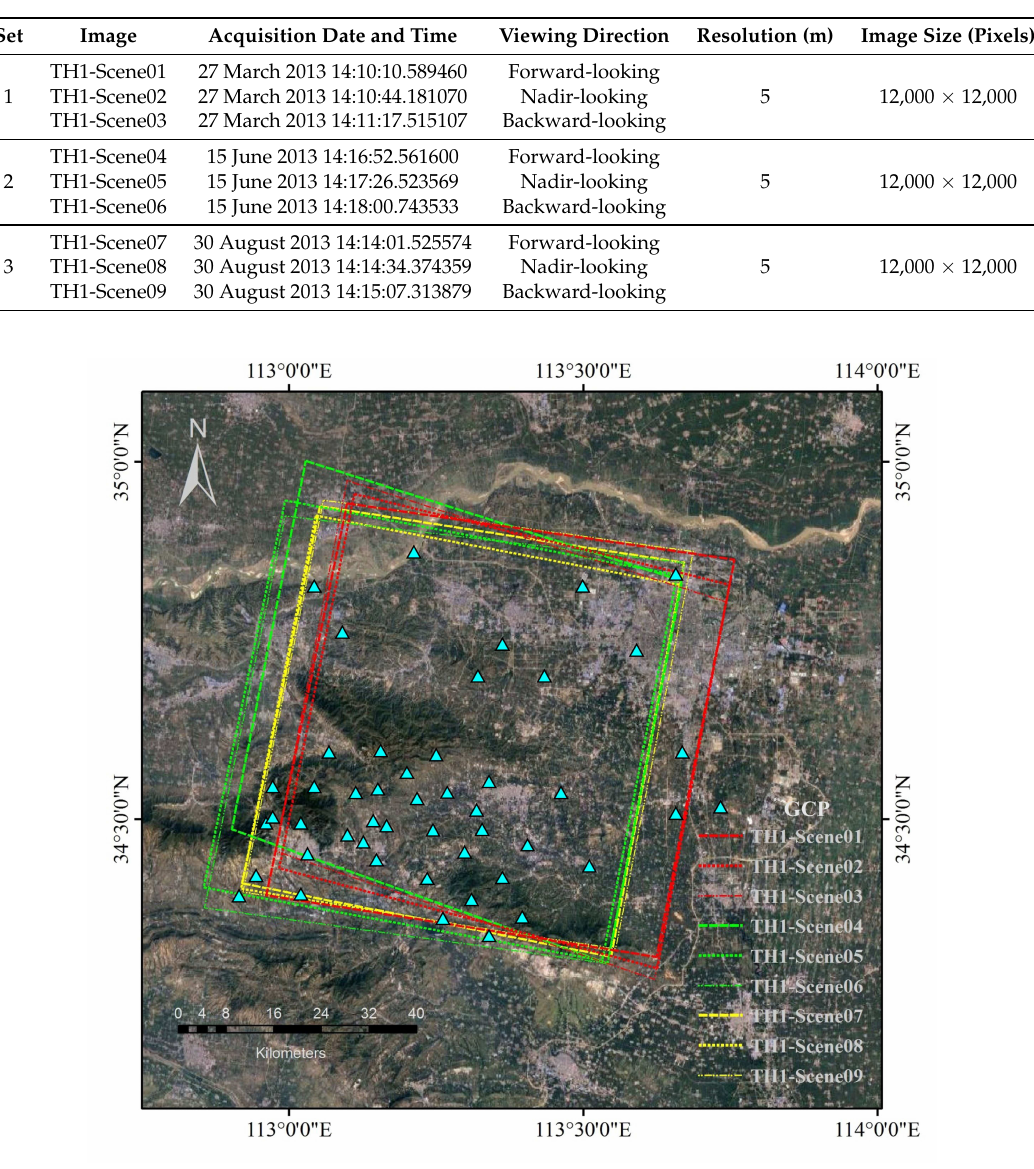
Figure 3. The extents of the nine TH-1 images in China and the GCPs distribution (The background map is downloaded from the Google